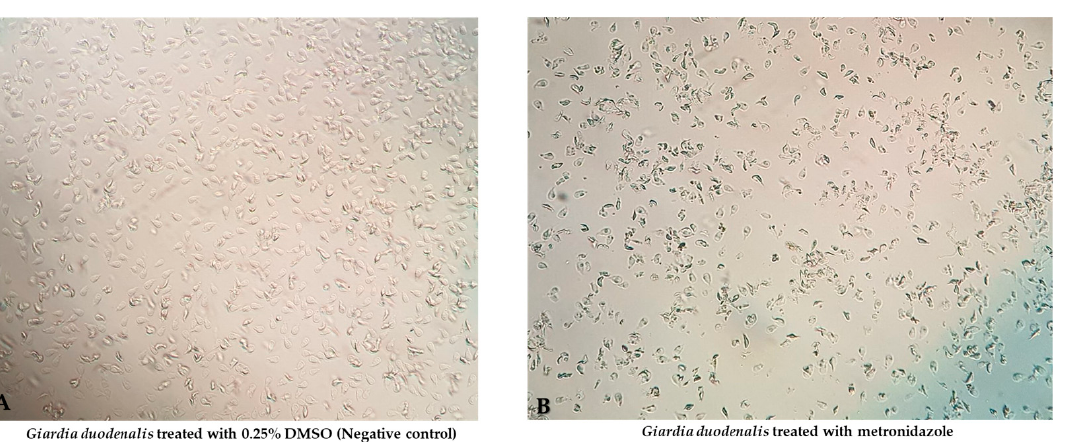
Figure 1. Morphological changes of G. duodenalis exposed to metronidazole: normal architecture of Giardia ( A ; 0.25% DMSO (Negative control)) compared with degenerated Giardia ( B ; metronidazole) were observed.